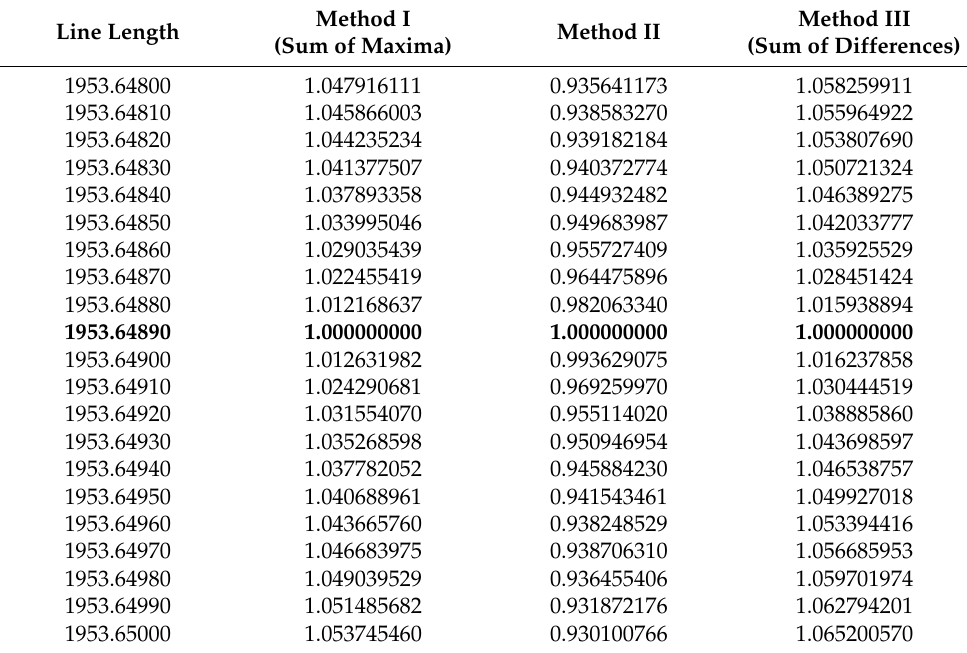
Table 7. Image line length estimation results for the accuracy ∆ = 0.0001.